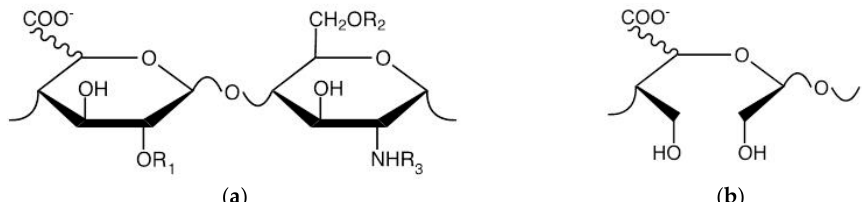
Figure 2. Structures and characteristics of synthesized HS competitors. The repeating disaccharide unit of compounds (R 1 and R 2 = H/SO 3 − , R 3 = H/SO 3 − /COCH 3 ) is shown. The uronic acid is predominantly in the form L -iduronic acid ( L -IdoA and L -IdoA-2- O -sulfate; ~80%) with D -glucuronic acid ( D -GlcA; ~20%) making up the remainder. ( a ) Structure of the canonical disaccharide building block of heparin; ( b ) The glycol-split uronic acid residue present in compounds C3 gs20 , MMW C3 gs90 and MMW C3 gs45 .